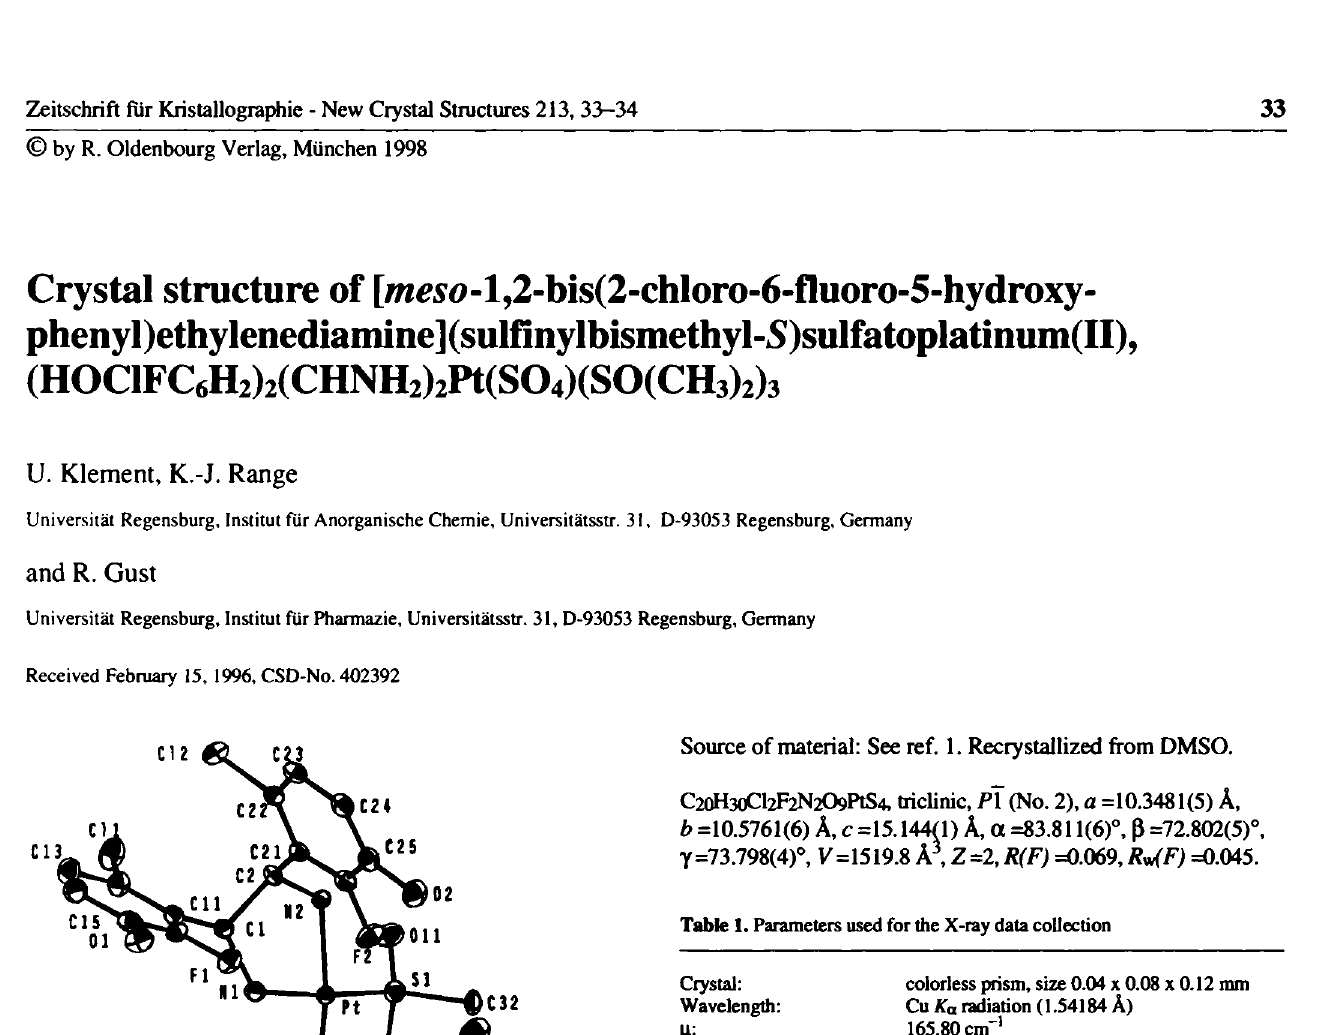
Table 2. Final atomic coordinates and displacement parameters (in Â^)